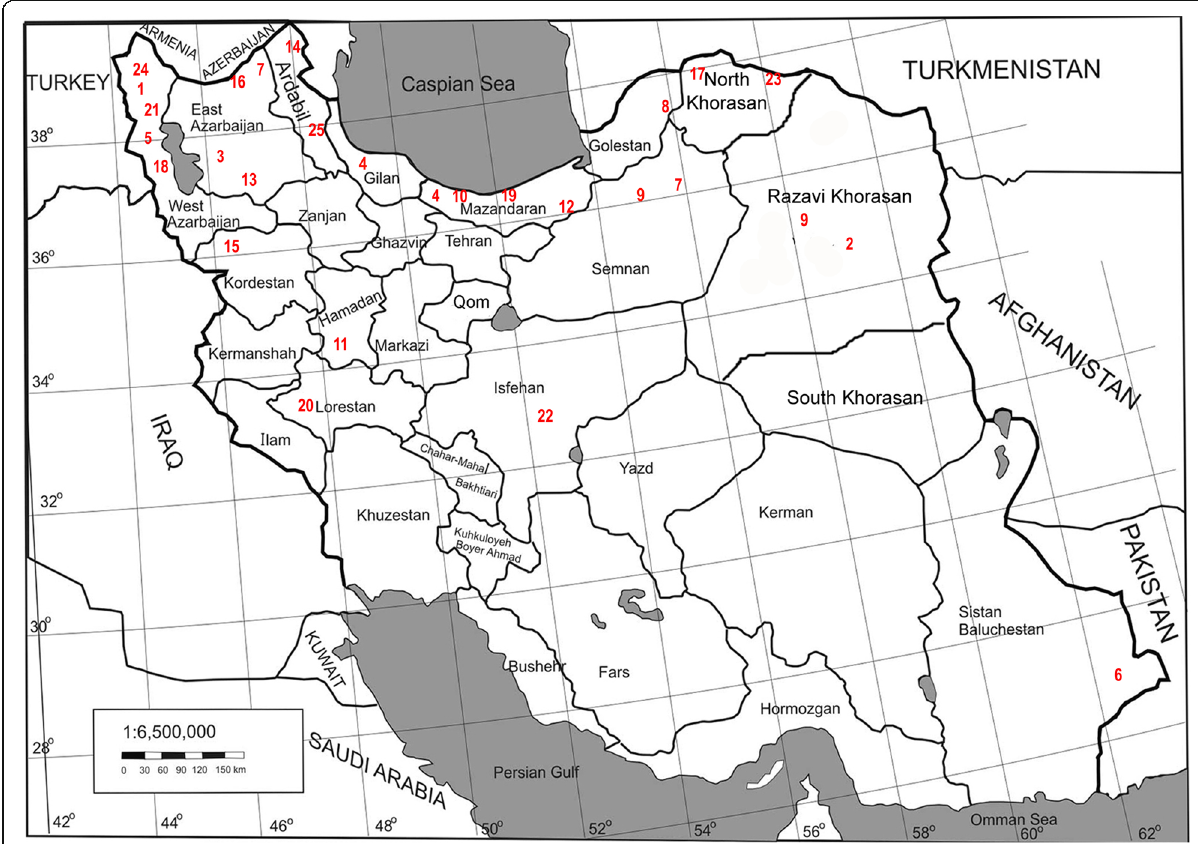
Fig. 1 Distributional data of newly recorded species in different provinces of Iran (numbers refer to species in the